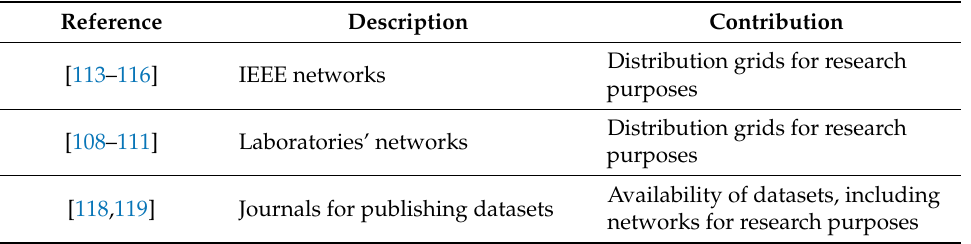
Table 4. A generic description of distribution networks availability for protection